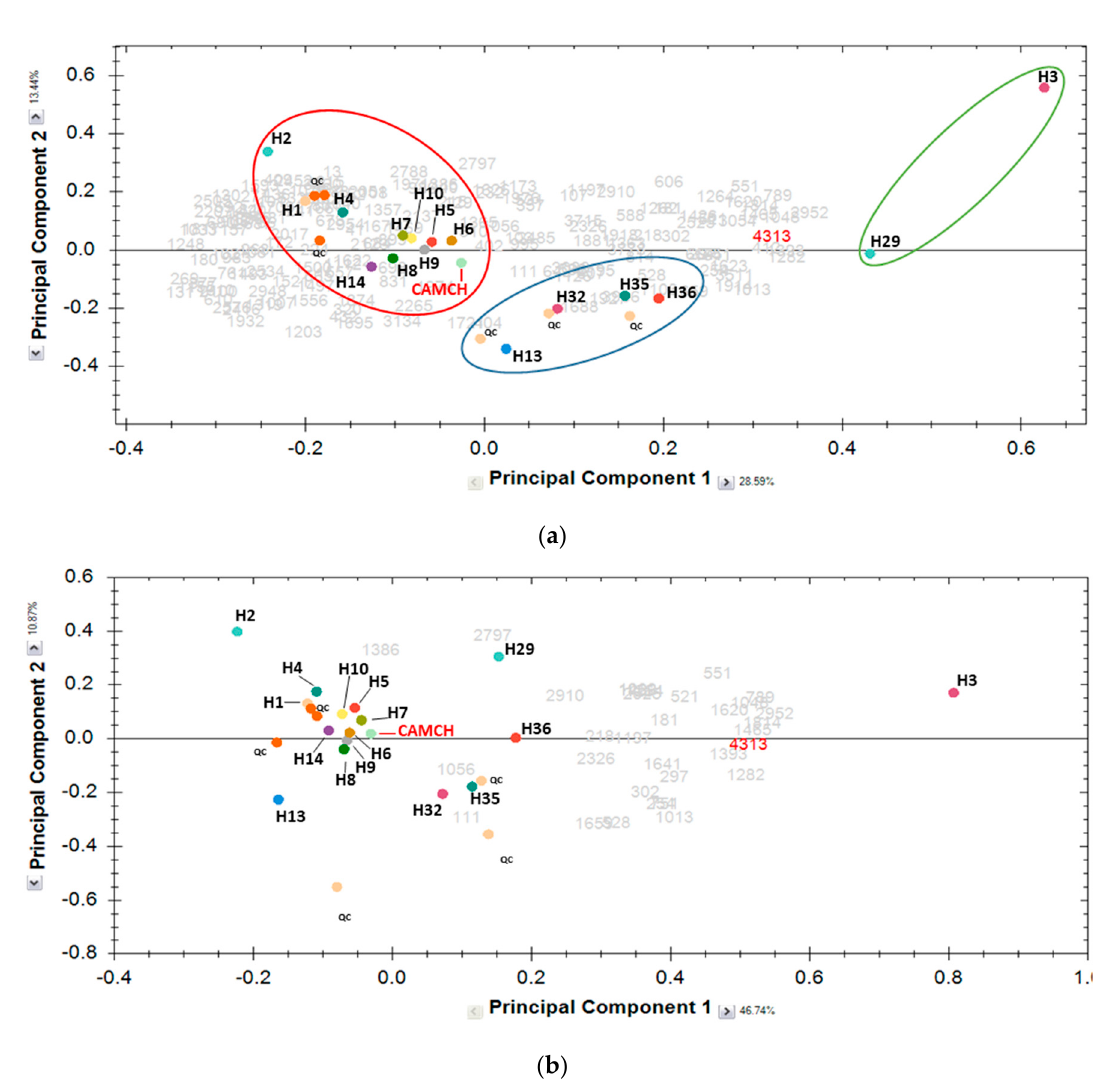
Figure 3. Principal component analysis of the most abundant identified peptides corresponding to the commercially available, unknown milk casein hydrolysate (CAMCH) and the 16 hydrolysates of ( a ) milk protein liquid fraction enriched in micellar caseins (ratio micellar caseins/whey proteins (92:8)) and ( b ) the 32 peptides (depicted in grey numbers) most abundant in H3 than in other hydrolysates (H13, H2, H14, H5, H1, H32, H4, H29, H36, and CAMCH). Principal components #1 and #2 of A explain 28.92% and 13.56% of variance, while principal components #1 and #2 of B explain 47.12% and 10.98% of variance, respectively. Grey numbers correspond to identified peptides displaying a mass signal intensity > to 1e4, while red number corresponds to one peptide of the H3 hydrolysate displaying the greatest fold change (infinity). Color circles are hand-marked to facilitate understanding and have no statistical significance.